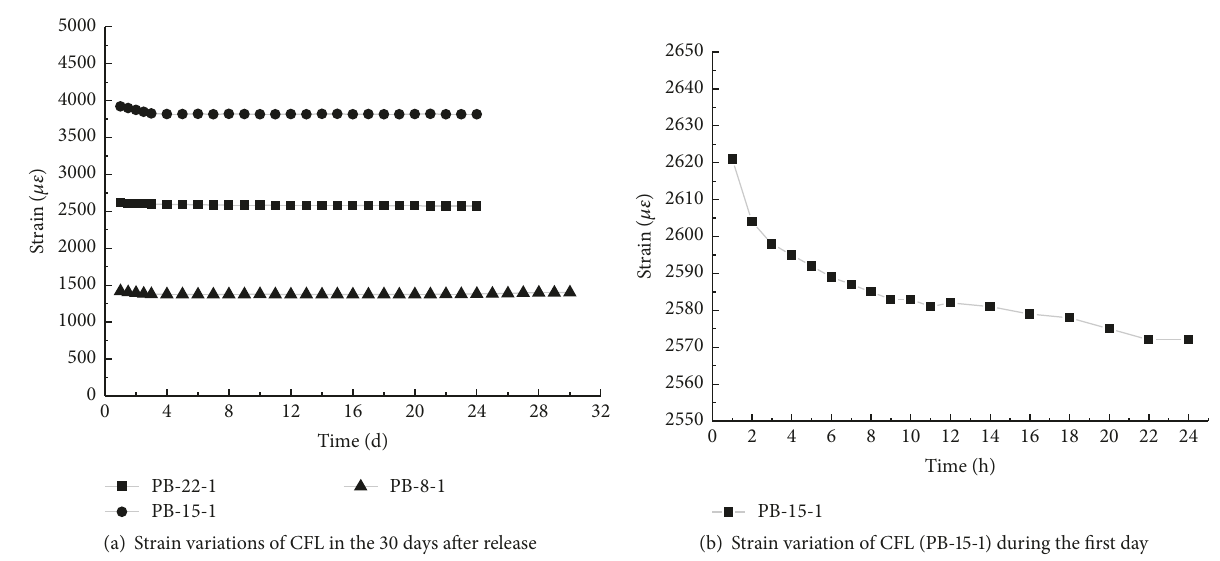
(b) Strain variation of CFL (PB-15-1) during the first day Figure 10: Long-term strain variations of CFL after